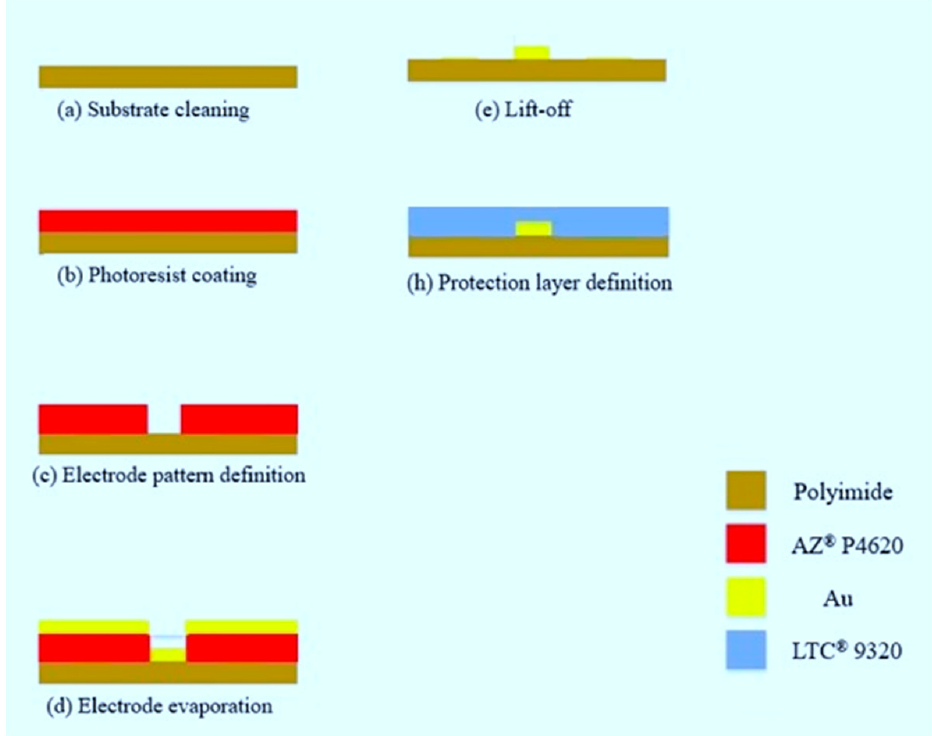
Figure 3. Fabrication process chart of the flexible micro air velocity sensor.